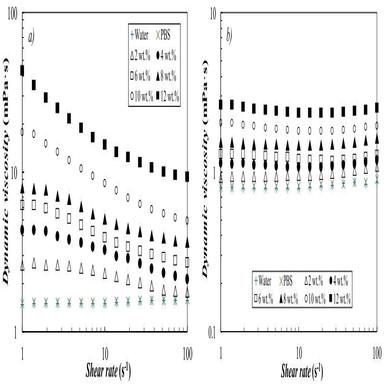
Shear rate− shear viscosity flow curves obtained for water, the phosphate buffer solution (PBS) and the optimized C18Me:C16:C14Me− in− water nanoemulsions prepared with different percentages of dispersed phase (2–12 wt%) at (a) 5 ◦C and (b) 30 ◦C.